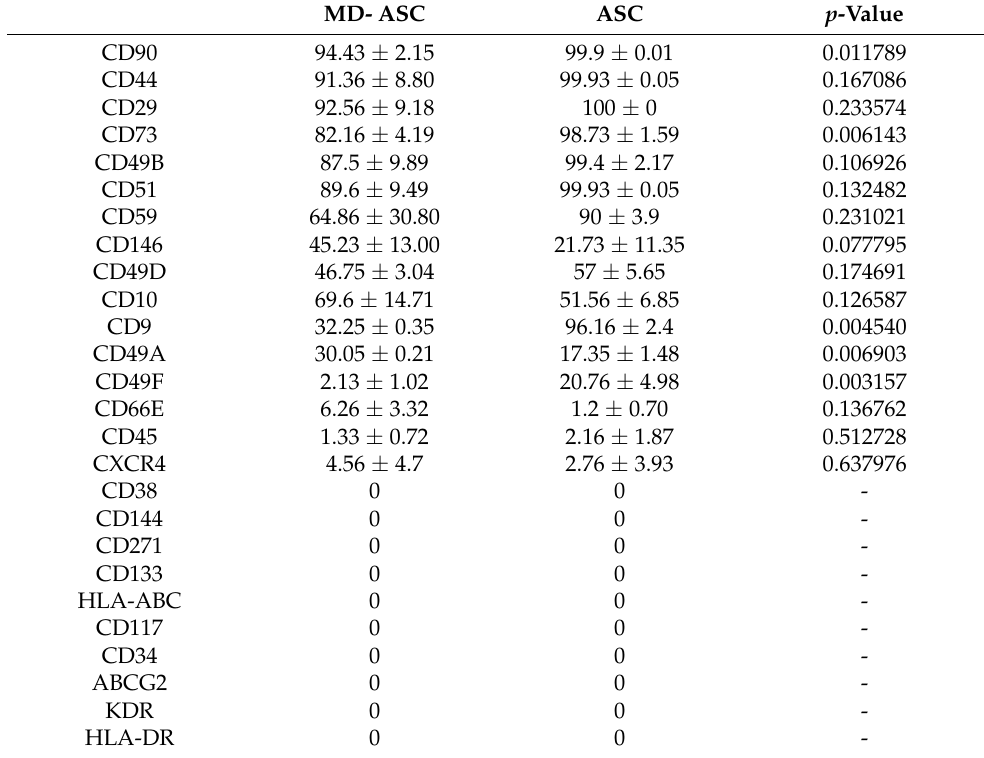
Table 2. Cell surface markers of MD-ASC and